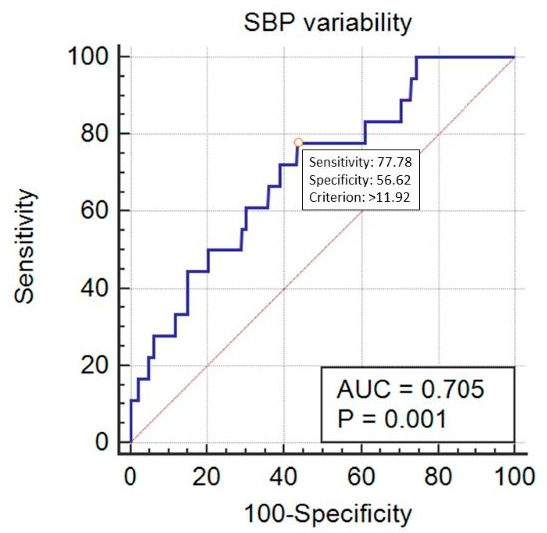
Figure 5. Prediction of mortality by the systolic blood pressure (SBP) variability (expressed as SBP_Cv in %).